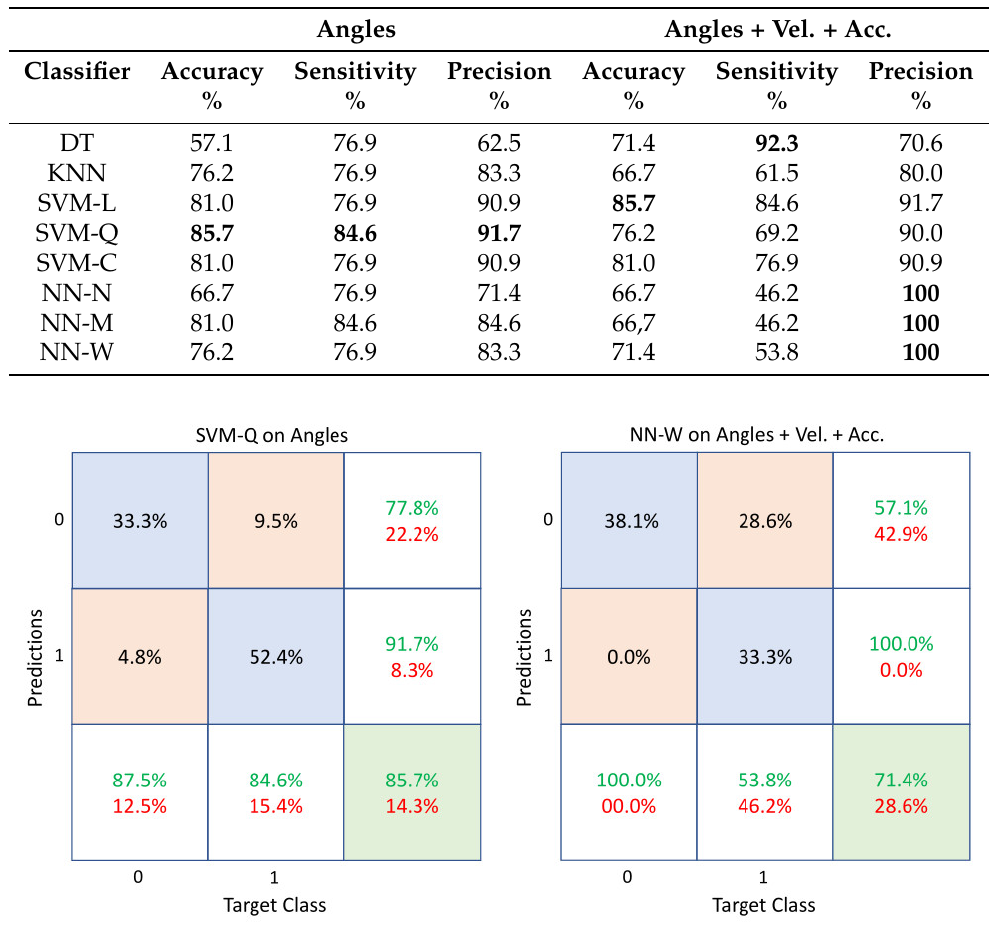
Figure 7. Confusion matrices of SVM-Q and NN-W when angles and angles plus velocity and acceleration were used as feature vectors, respectively. The diagonal cells show the correctly classified observations (accuracies), whereas the off-diagonal cells show the incorrectly classified ones. The far-right column of each matrix shows the precision or positive predictive value (green) and the false discovery rate (red). The bottom row shows the sensitivity or true positive rate (green) and the false negative rate (red). Class 0 and class 1 represent healthy subjects and sick patients, respectively.